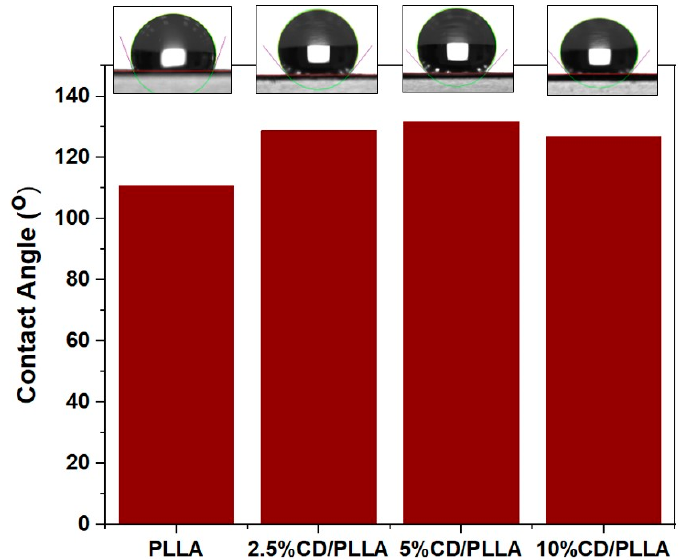
Figure 5. Contact angle of electrospun PLLA compared with 2.5, 5, and 10 wt% CD/PLLA.